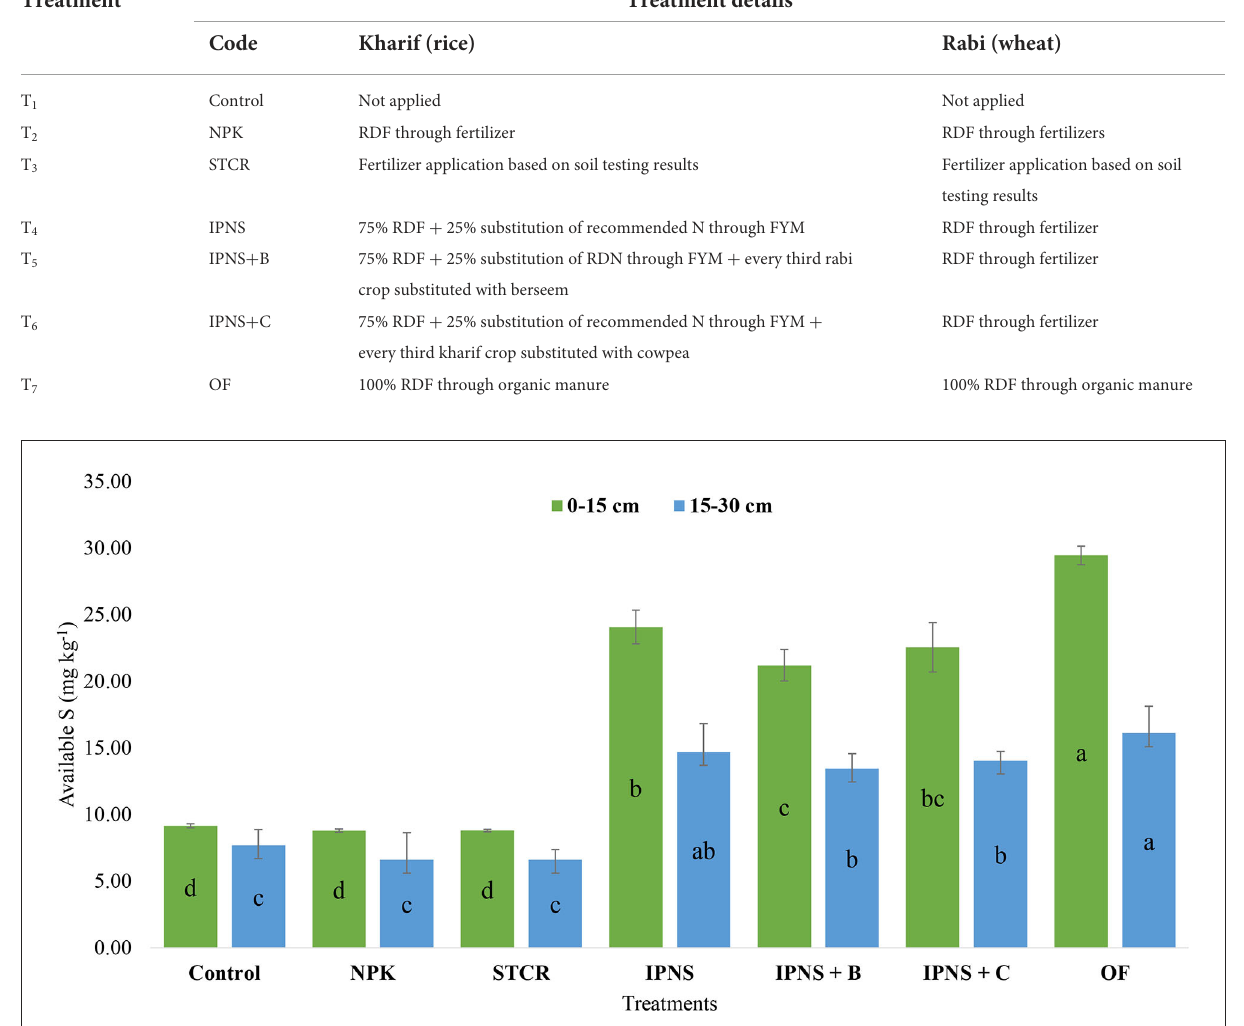
FIGURE3 Effect of long-term fertilization on soil available S in the 0–15 and 15–30cm soil layer of rice-wheat cropping system (RWCS). Means of different treatments followed by the different lower-case letters (a–d) are significantly different at p < 0.05 levels of significance according to Duncan’s multiple range test